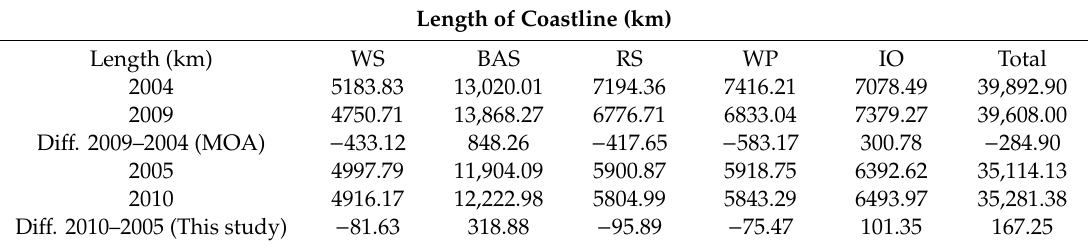
Table 6. Deviation of coastline length in each sector (km) between MOA products (2004 and 2009) and our results (2005 and